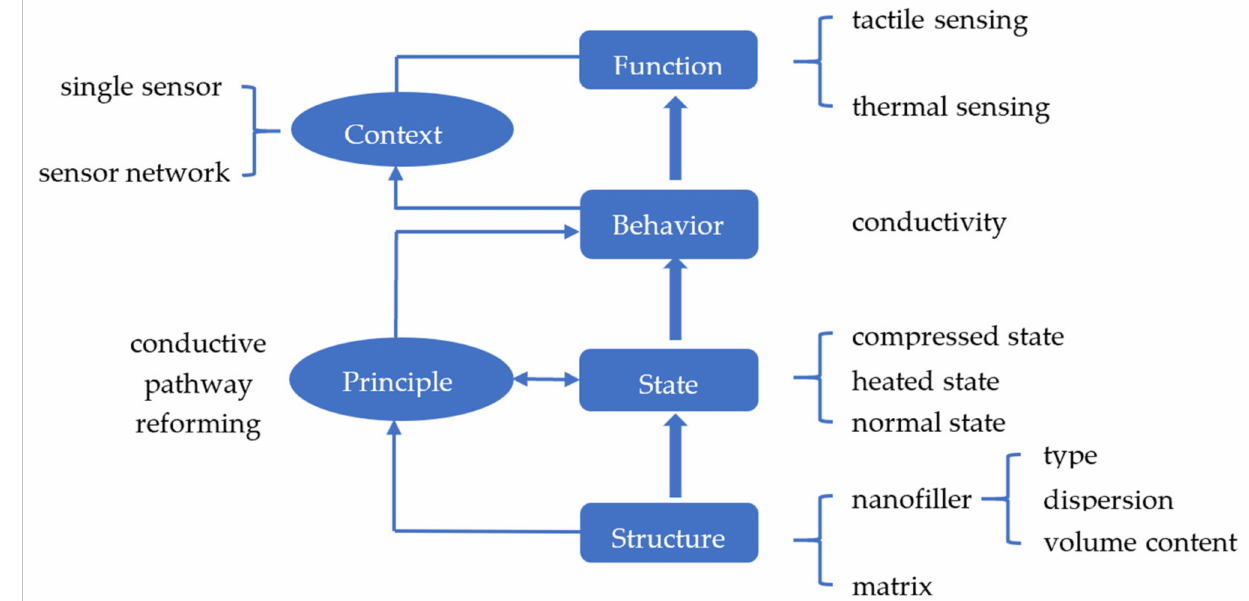
Figure 1. The framework of carbon nanomaterial-filled polymer